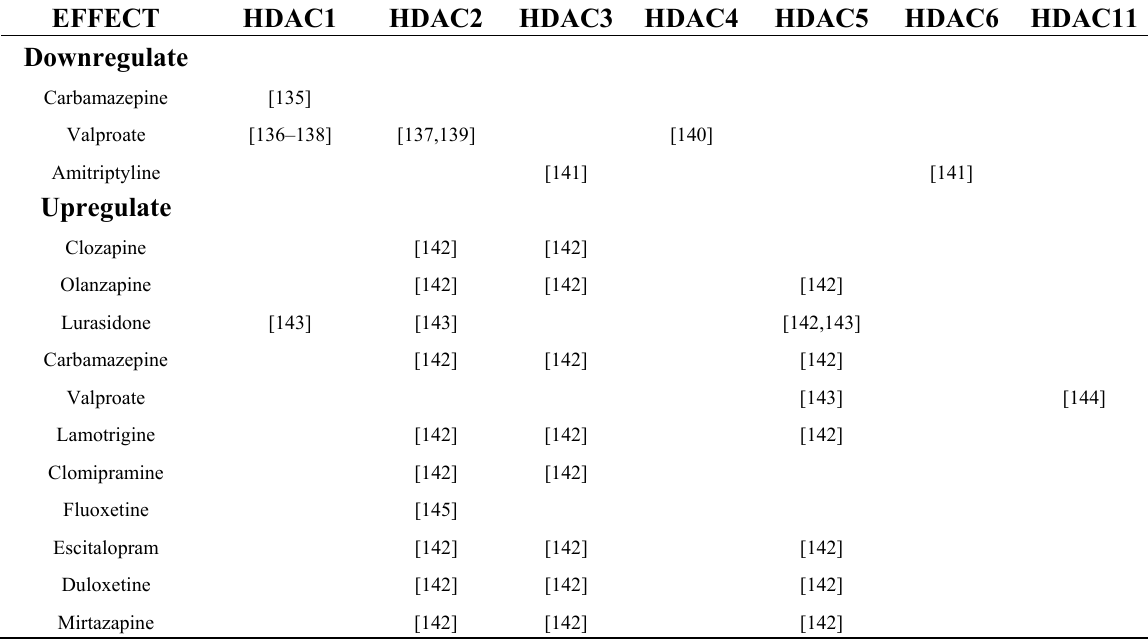
Table 3. Psychotropic effects on Histone Deacetylases